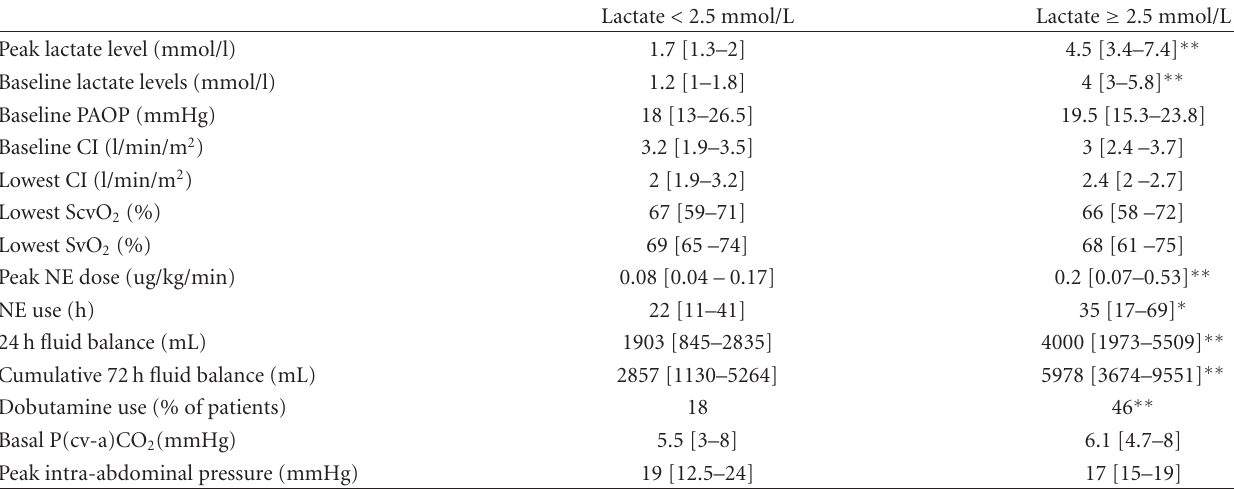
Table 3: Hemodynamic and perfusion parameters in subgroups of patients.